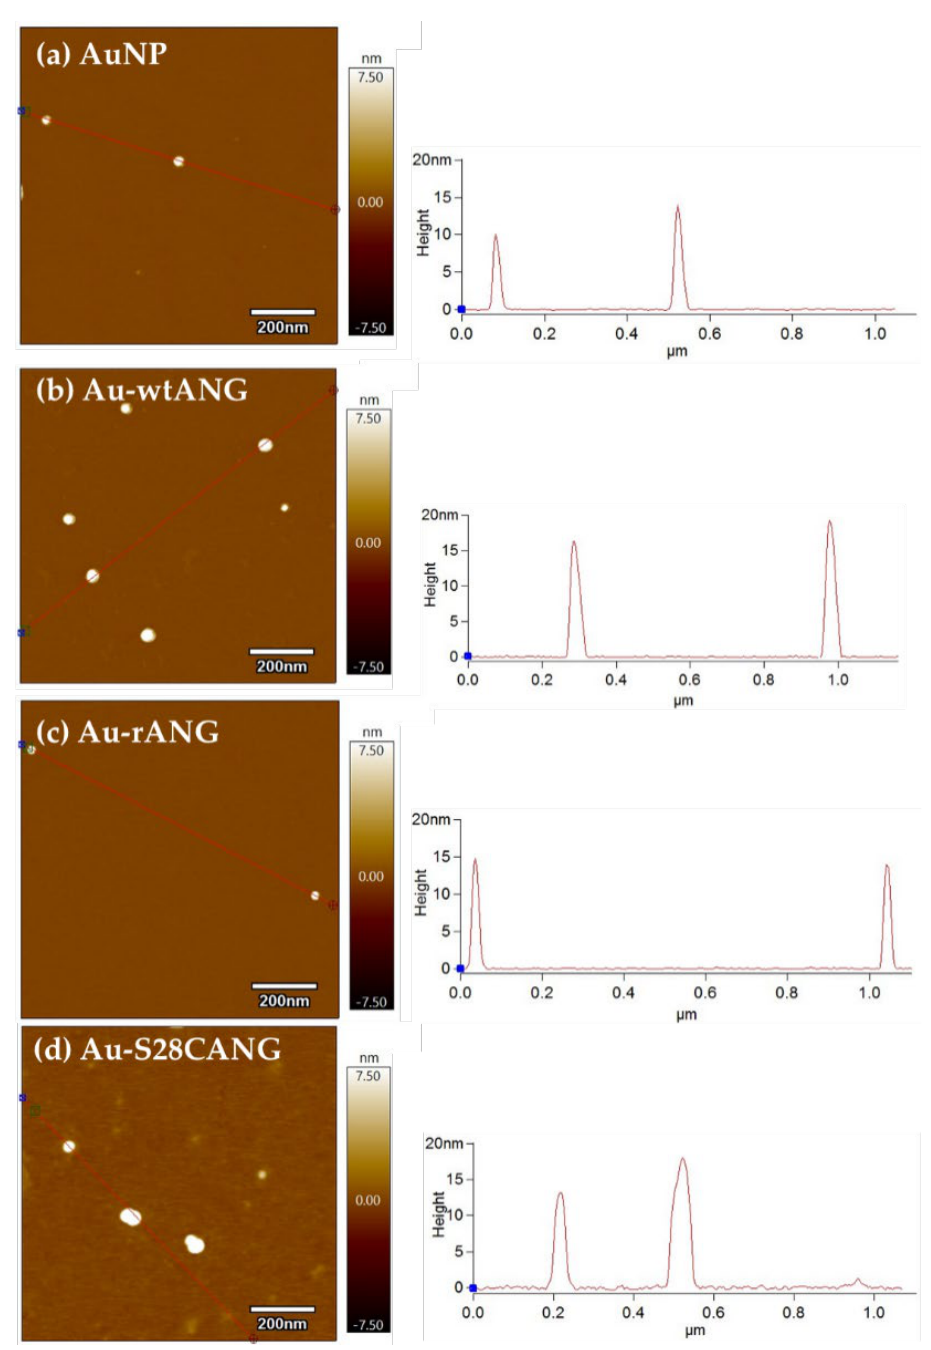
Figure 4. Atomic force microscopy micrographs of ( a ) bare AuNP, ( b ) Au-wtANG, ( c ) Au-rANG and ( d ) Au-S28CANG pellets; scale bar = 200 nm. The graphs on the right of each image show the histograms calculated for Z max.